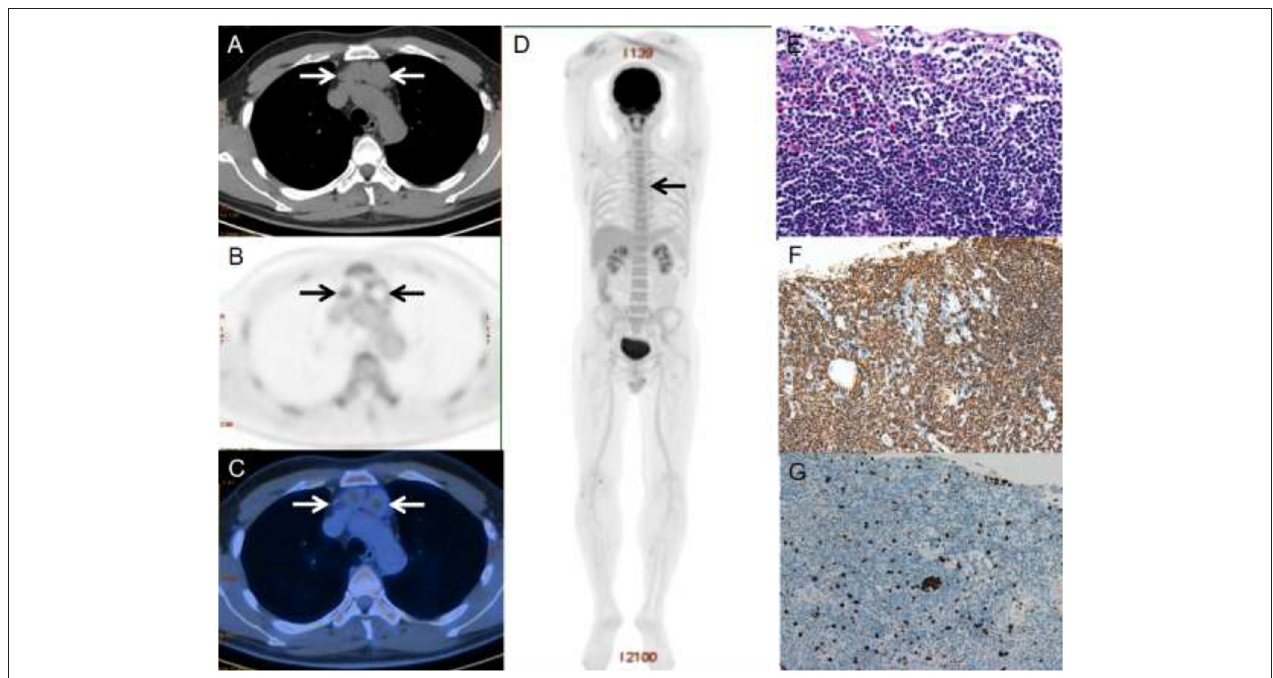
FIGURE 1 | A 40-year-old male with primary thymic MALT lymphoma. PET/CT revealed multilocular cystic nodules with moderate 18 F-FDG uptake (SUV max = 5.0) in the anterior mediastinum, which was measured 2.6 × 3.6cm in size (A–C) . Three-dimensional maximum intensity projection image (D) shows mild 18 F-FDG-avid lesion in the anterior mediastinum (black arrows). HE staining revealed diffuse infiltrate of lymphoid cells replacing thymus tissue and all the cysts wall remained clear margin (E) . The immunophenotypic examination showed B-cell phenotype (CD20 positive) (F) . Ki-67 was 3% ∼ 5% (G)